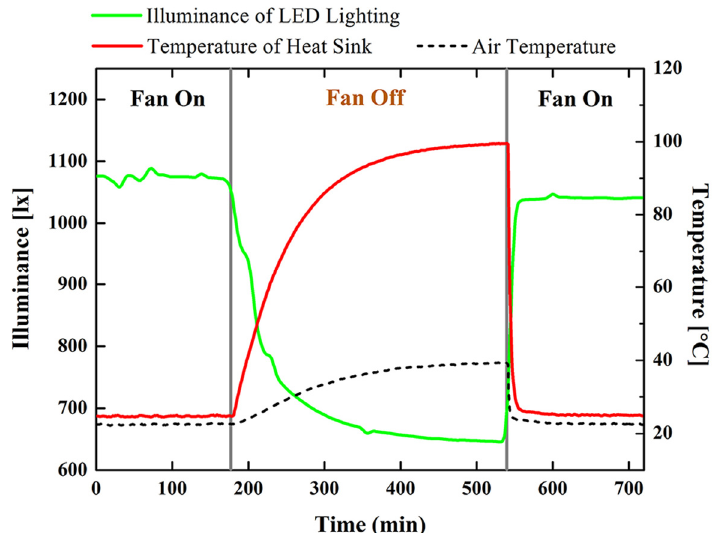
Figure 4. Variation in illuminance of LED lighting and heat sink temperature under active and normal cooling.